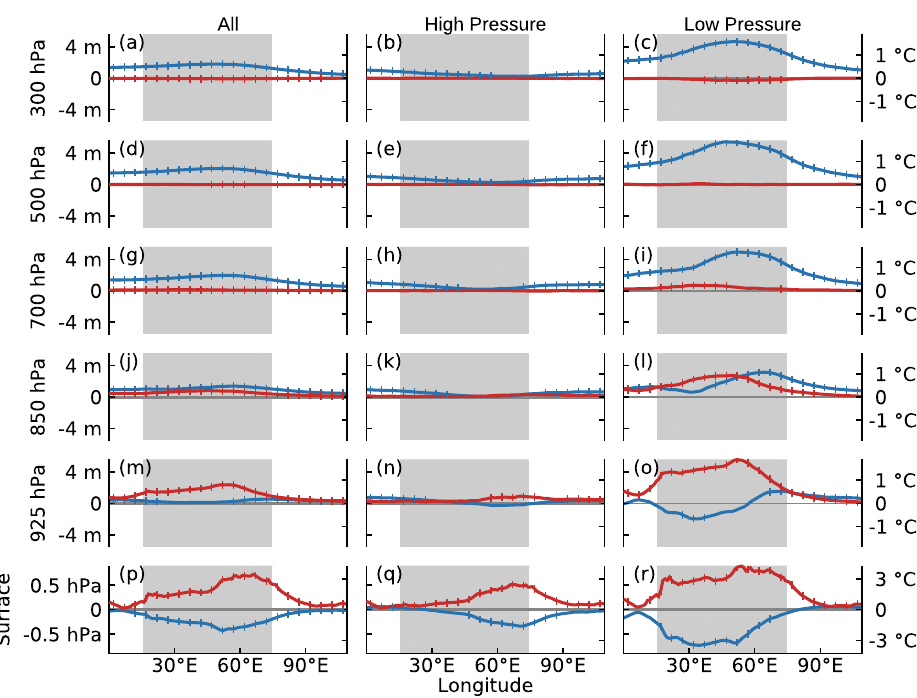
Figure 3. Zonal structure near the Barents Sea region (averages for 70–80°N) for all ( a , d , g , j , m , p ), “high- pressure” ( b , e , h , k , n , q ), and “low-pressure” ( c , f , i , l , o , r ) cases. Red lines indicate temperature response. Blue lines indicate surface pressure responses at surface level ( p , q , r ) and geopotential height responses in the atmosphere ( a – o ). The left y-axes are surface pressure in hPa ( p , q , r ) and geopotential height in meters ( a – o ). The right y-axes are temperature, and note that the scale for surface ( p , q , r ) is different from that for atmopshere ( a – o